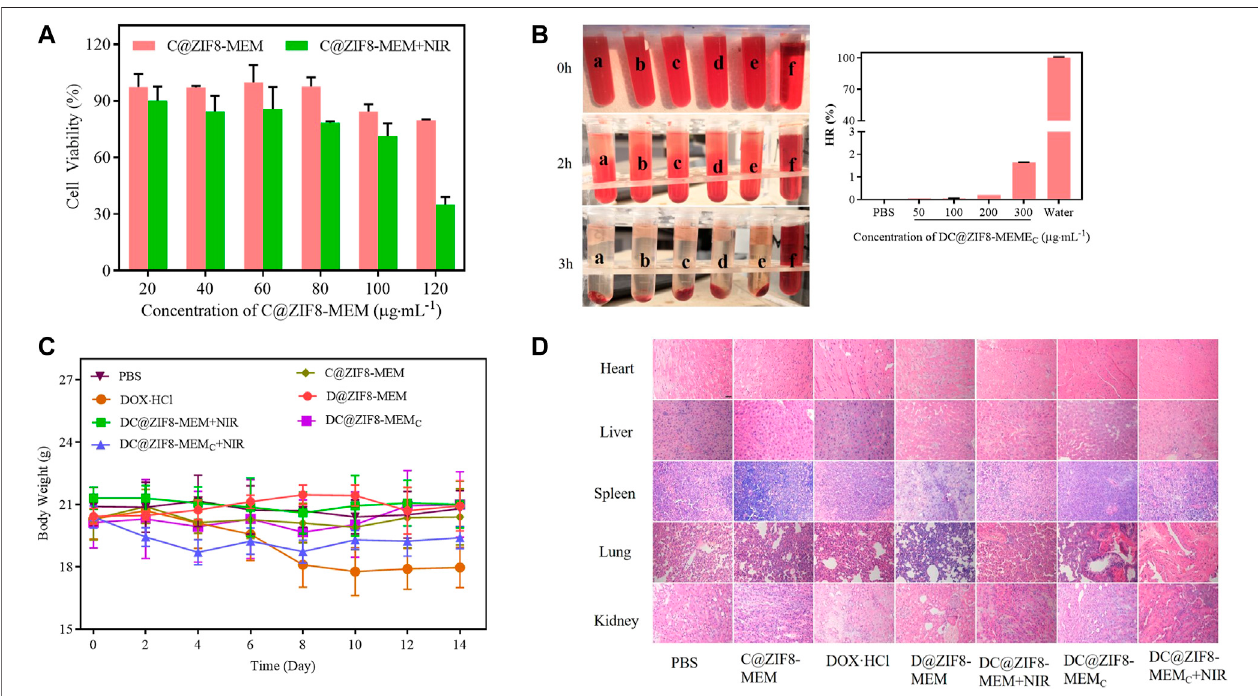
FIGURE7| CellviabilityofC@ZIF8-MEMto4T1cellswithandwithoutNIR (A) .Thehemolyticimage(left)andhemolysisratioofsamples(right),PBS(a),50 μ g · mL − 1 DC@ZIF8-MEM C (b), 100 μ g · mL − 1 DC@ZIF8-MEM C (c), 200 μ g · mL − 1 DC@ZIF8-MEM C (d), 300 μ g · mL − 1 DC@ZIF8-MEM C (e), deionized water (f) (B) . Body weights of mice with different treatments (C) . H&E analysis of major organs from mice after treatments; scale bar = 20 µm (D)